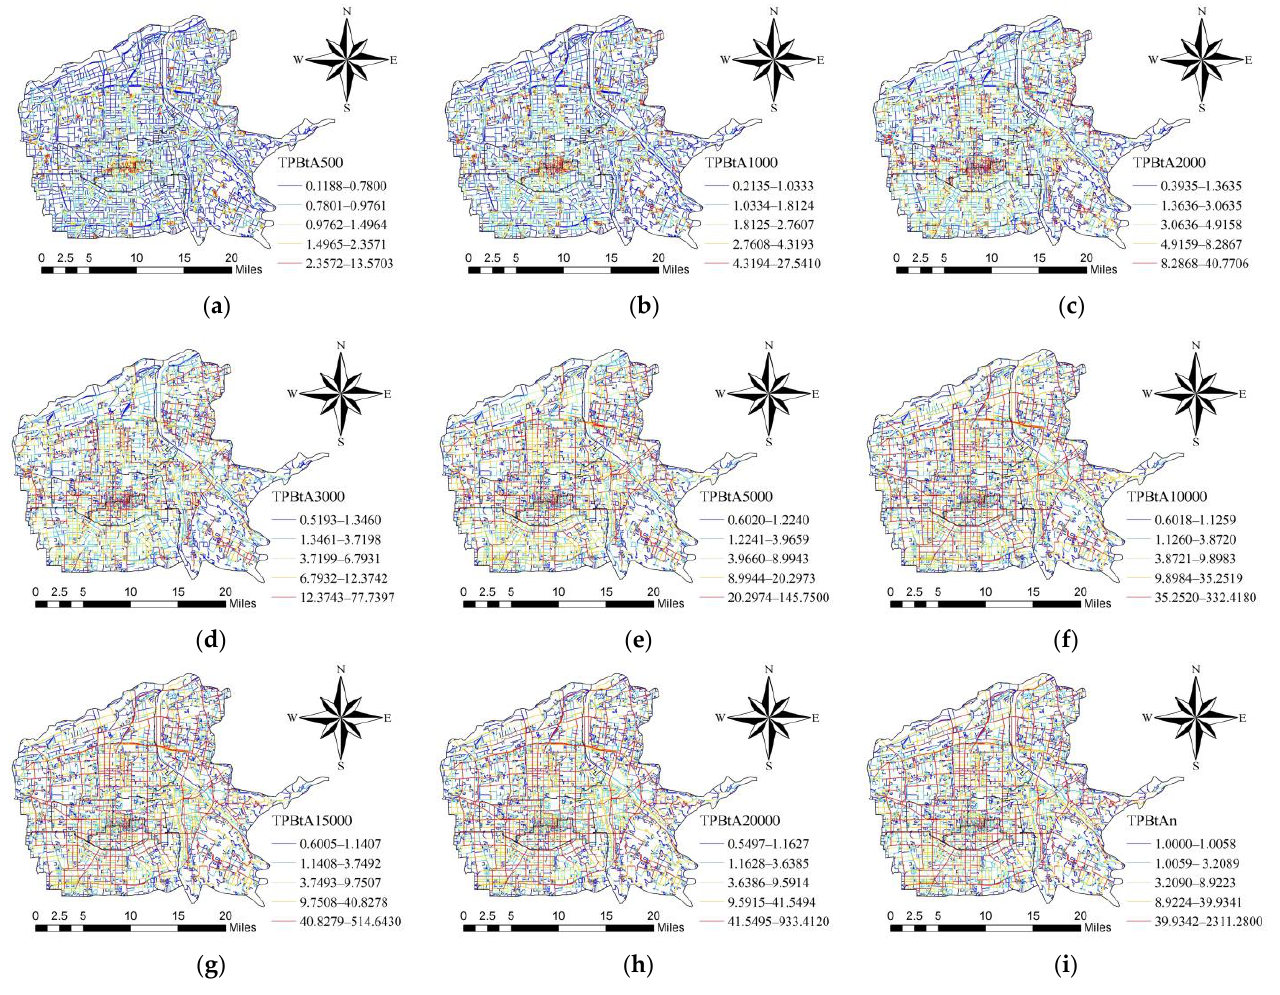
Figure 5. The betweenness of the road networks at different scales in the main urban area of Xi’an (R denotes search radius). ( a ) R = 500 m; ( b ) R = 1000 m; ( c ) R = 2000 m; ( d ) R = 3000 m; ( e ) R = 5000 m; ( f ) R = 10,000 m; ( g ) R = 15,000 m; ( h ) R = 20,000 m; ( i ) R = n.